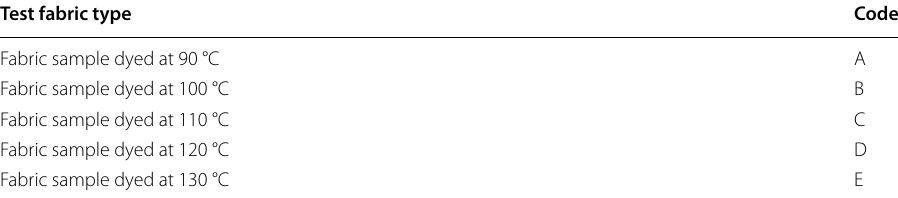
Table 1 Test fabric sample